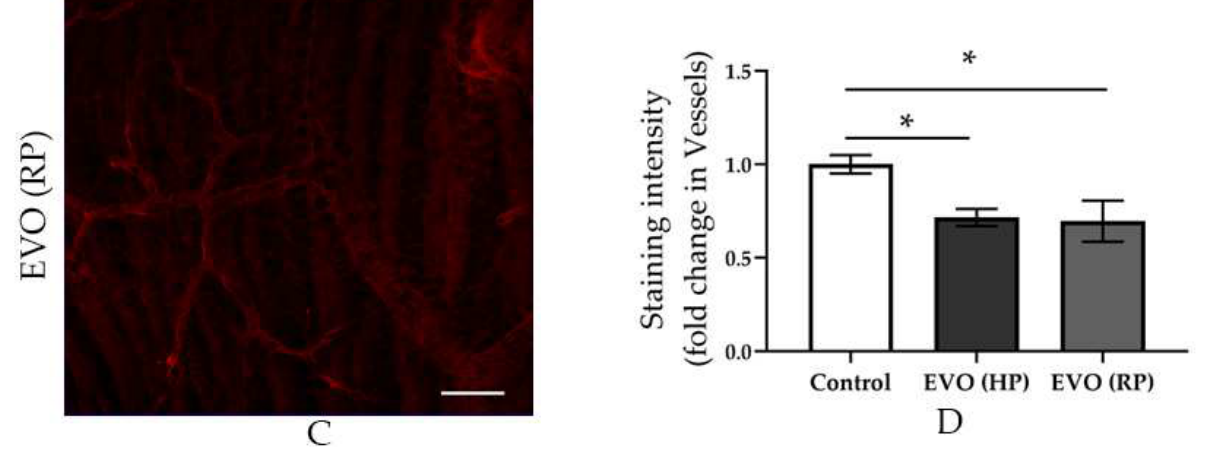
Figure 6. Immunostaining of anti- α -SMA and quantitative analysis of its fluorescence intensity in retinal flatmounts. The immunostained retinal flatmounts from the control group ( A ), the EVO (HP) group ( B ), and the EVO (RP) group ( C ). The staining intensity comparison among three groups ( D ). EVO: episcleral vein occlusion; HP: high intraocular pressure; RP: recovered intraocular pressure. Control group refers to the sham group. Values are expressed as mean ± SEM (* p < 0.05; n = 6 per group, scale bar = 50 µ m).